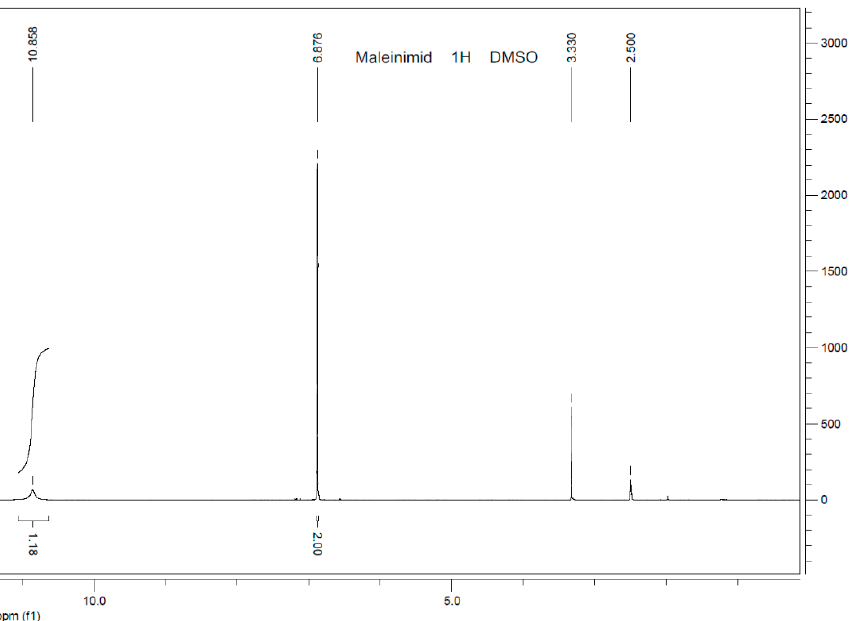
Figure A13. 1 H NMR spectrum of maleimide in d 6 -DMSO with the characteristic signal of the double bond at 6.88 ppm.